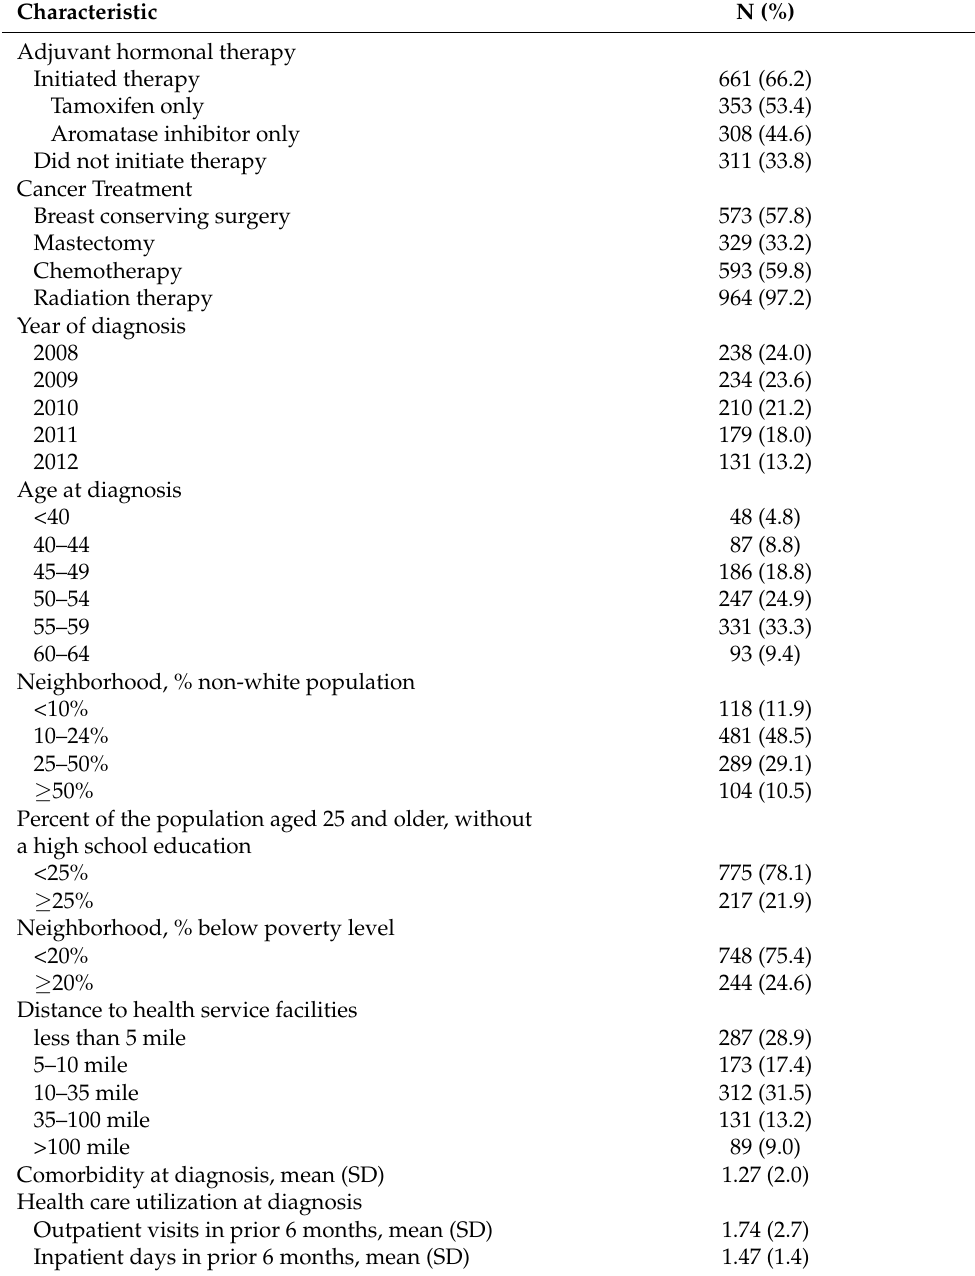
Table 1. Descriptive statistics for the study